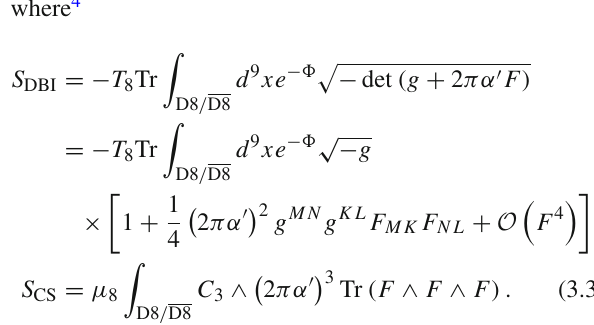
Fig. 2 The D-brane configuration involving the heavy flavour in the X 4 − U plane. Additional to the light flavour branes, a pair of heavy flavour D8 / D8-brane (H) (denoted by the red line) is introduced in to the D4/D8 configuration which is separated from the light flavour branes. The heavy flavour D8 / D8-branes are connected to each other at U = U H > U KK andthemassivemultipletsareproducedbytheheavy- light string (HL-string denoted by the green line) stretched between the light and heavy flavour branes which is denoted by the green line in this figure ( 1 ) ( 0 ) ( x ) = U π ( x ) with identify B μ ( x ) = ρ μ ( x ) , ϕ KK